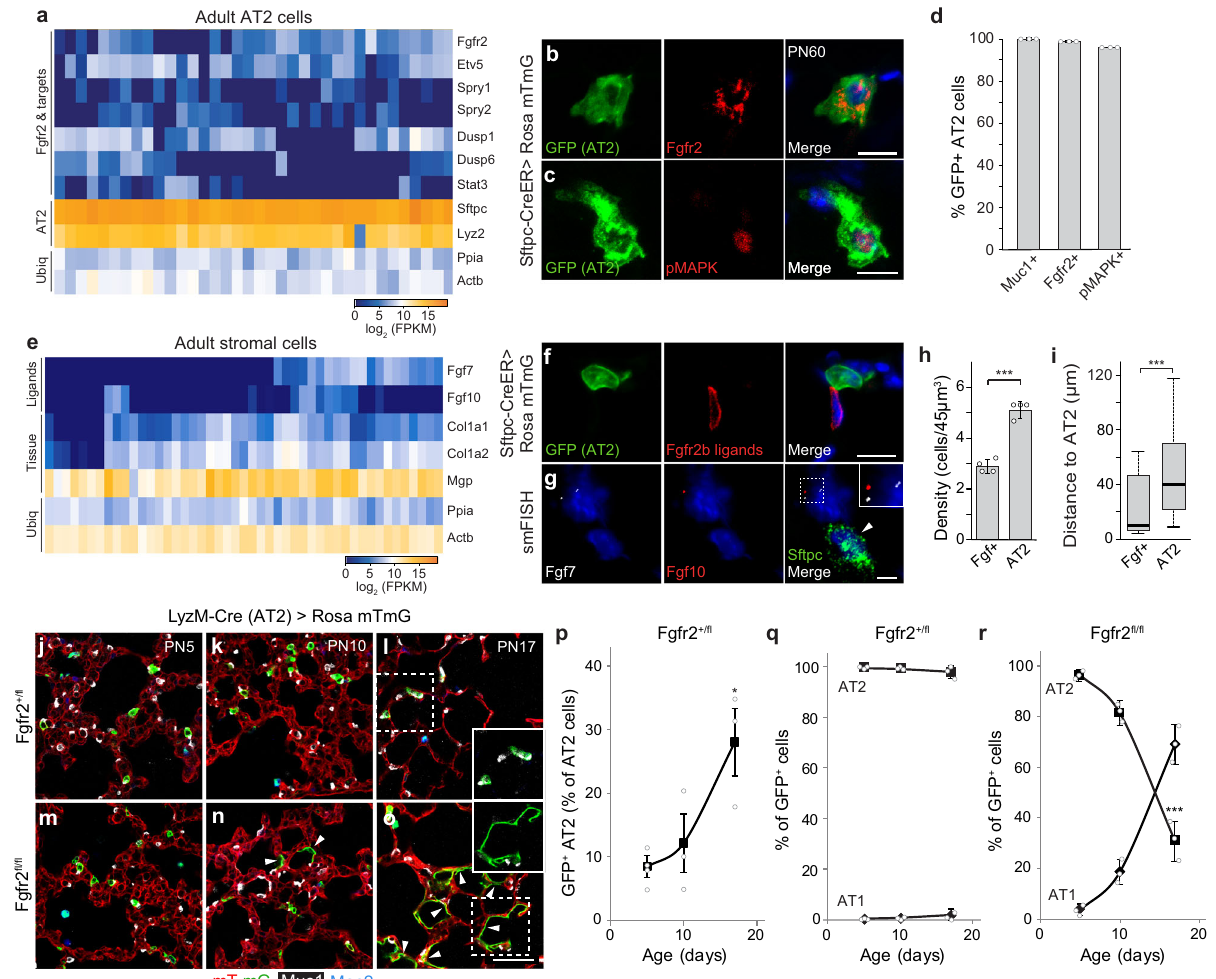
Fig. 5 | Fgfr2 pathway prevents AT2 reprogramming to AT1 after birth. a scRNAseqofadultAT2cells.Expressionof Fgfr2 ,downstreamtranscriptionfactor Etv5 , and targetgenesindicates pathwayremains on afterbirth. AT2, AT2markers; Ubiq, ubiquitously-expressed genes. b , c AT2 in adult (PN60) Sftpc-CreER;Rosa26- mTmG mousetamoxifen-inducedtolabelAT2(GFP)andco-stainedforFgfr2( b )or phosphorylated MAP kinase (pMAPK) to show pathway activity ( c ). Blue, DAPI counterstain. Bars, 10 µ m. d Quanti fi cation of b , c . Nearly all labeled cells (GFP + ) express AT2 marker (Muc1) and Fgfr2, and show Fgfr2 activity (pMAPK + ). n =300 GFP + cells scored (three animals). e Fgfr2 ligand expression (scRNAseq) in lung stromalcells. f AT2inadult Sftpc-CreER;Rosa26-mTmG mousetamoxifen-inducedto label AT2 (GFP + ) and co-stained for Fgfr2 (isoform iiib) ligand-binding domain to show Fgfr2 ligands (ligands identi fi ed in Supplementary Fig. 2). Blue, DAPI. Bar, 10 µ m. g smFISH ( Fgf7 , Fgf10 , Sftpc ) in adult (PN60) lung. Cell neighboring AT2 co- expresses Fgf7 (white dots) and Fgf10 (red dots) (enlarged in inset). Blue, DAPI; arrowhead, AT2. Bar, 5 µ m. h , i Quanti fi cation of g showing the density of Fgf - expressing and AT2 cells ( h , *** p =4.8×10 − 5 , Student ’ s two-sided t -test, data